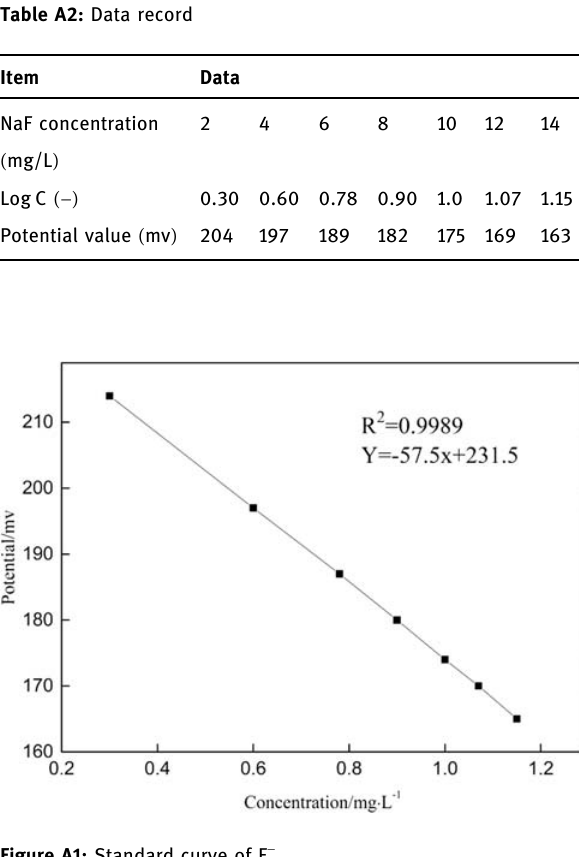
Figure A1: Standard curve of F −